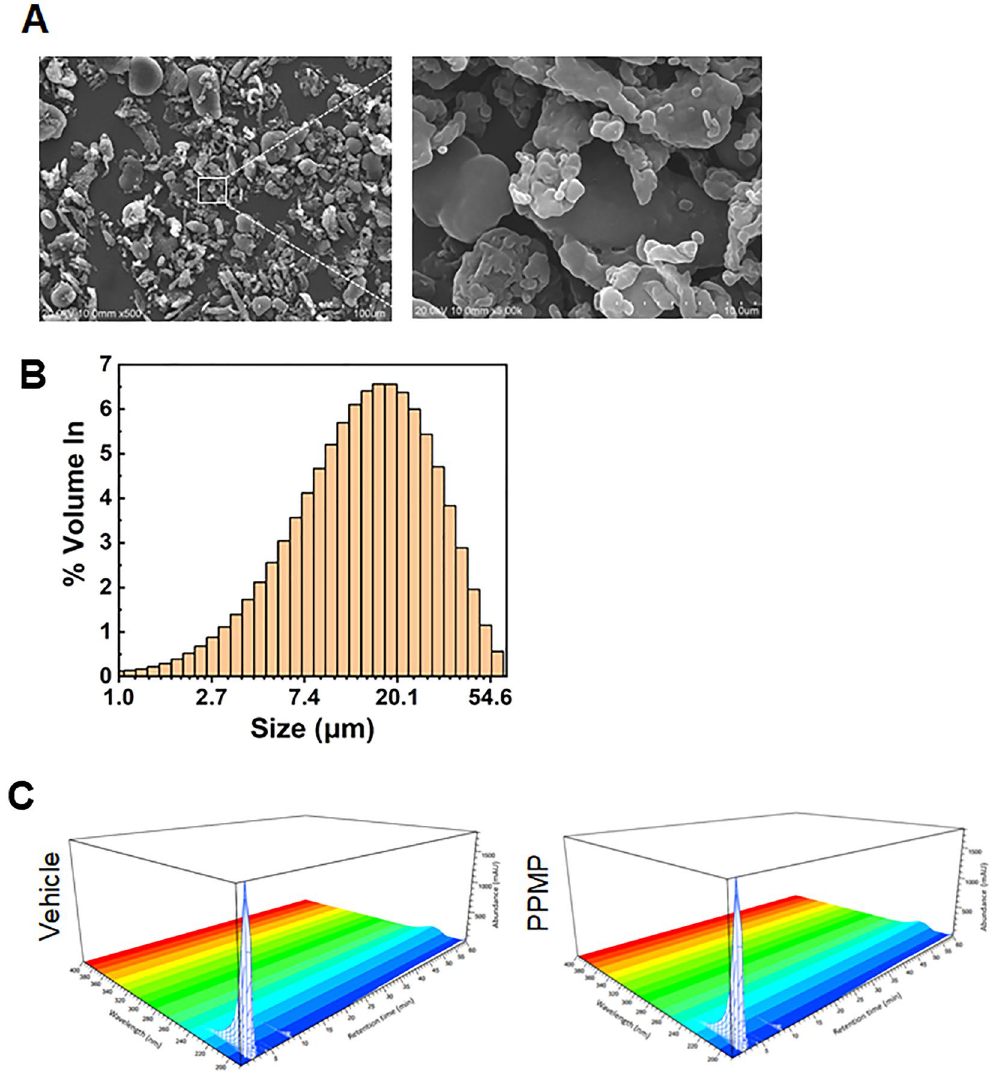
Figure 1. Characterization and SEM images of the PPMPs ( A ) SEM images of the fragment type PPMPs ( B ) The particle size distribution plot of the PPMPs indicates that the PP particles have the largest volume density (%) at 16.40 μm. ( C ) Comparison of the HPLC chromatograms before (left, Vehicle) and after the microplastic treatment at the selective adsorptions (right,